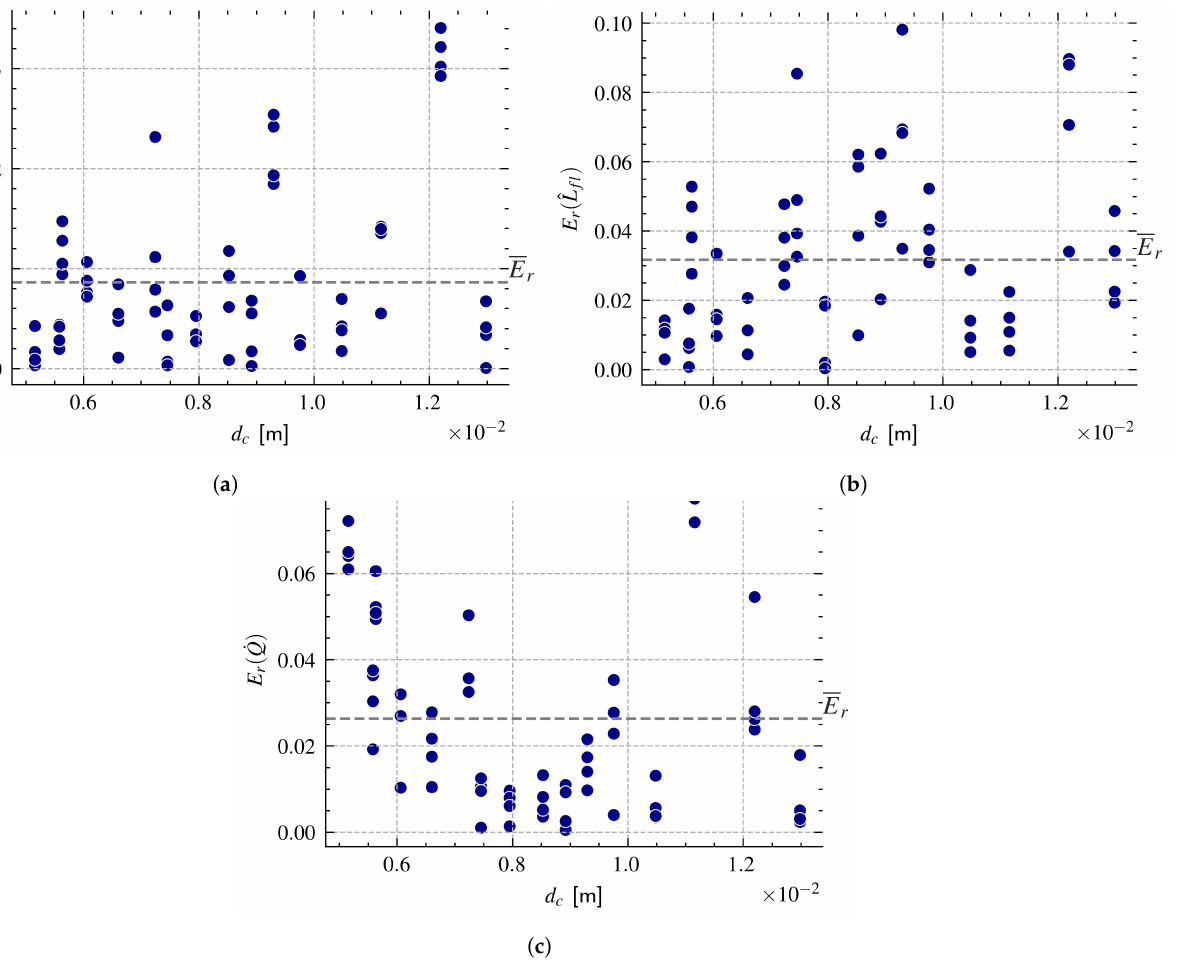
Figure 4. Scatter plots of the relative errors of the best-performing networks, for every fold and sample of DS2 as a function of the sample d c coordinate of each of the global quantities: ( a ) c ∗ ( b ) ˆ L fl , and ( c ) ˙ Q . The average error across samples and folds is highlighted in gray for every